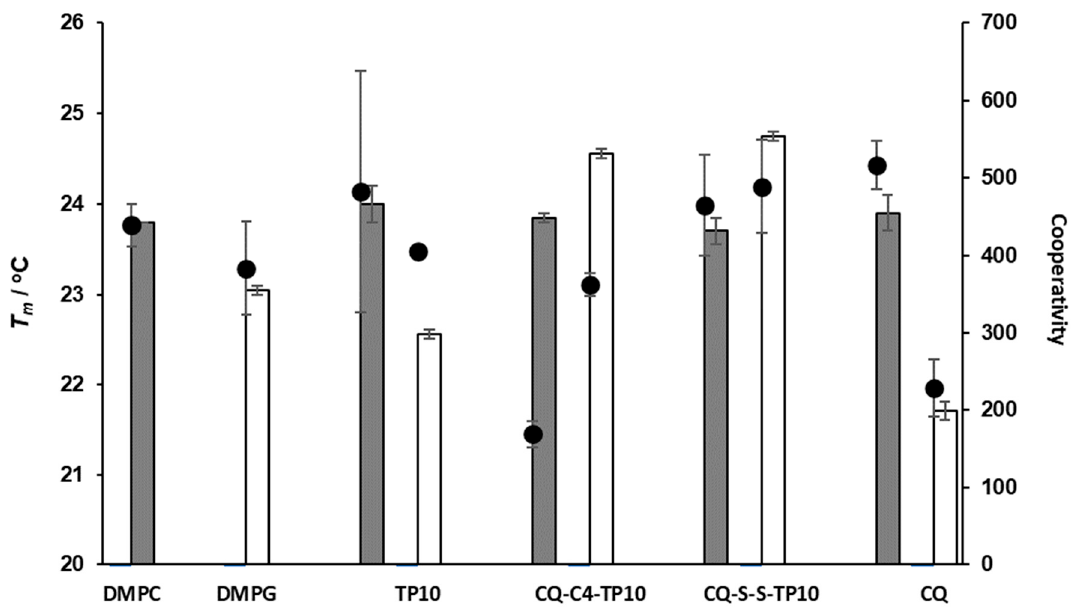
Figure 6. Main phase transition temperature ( T m , bars) and cooperativity (B, dots) of DMPC and DMPG liposomes alone and in the presence of CQ (at 20 µM), TP10, CQ-C4-TP10, and CQ-S-S-TP10 (at 5 µM).